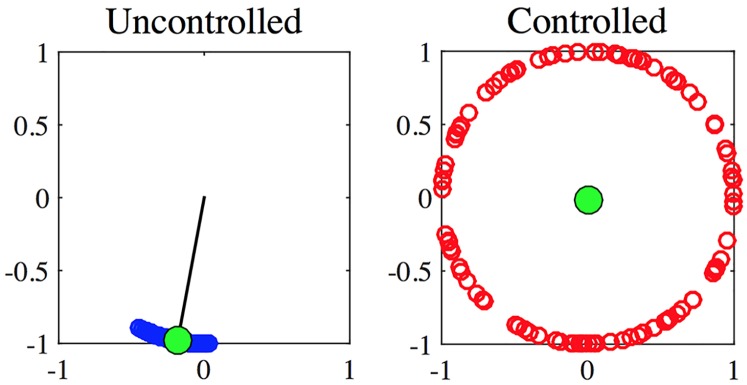
A snapshot of the Kuramoto dynamics at a generic time.N = 100 oscillators (circles) are drawn on the unitary circle, their angular position is given by the oscillator phase. The dynamical behaviour presented in panel a) corresponds to the uncontrolled phase-locked regime for a coupling parameter K = 0.5. In panel b) we report, for the same coupling parameter, the controlled case obtained acting on M = 20 oscillators and γ/4 = 4.25, resulting in a desynchronised behaviour. The underlying network is a Newman-Strogatz small-world network [55] with parameter p = 0.85. The green circle represents the Kuramoto order parameter, its angular position is given by the angle Ψ while its distance from the origin is R.